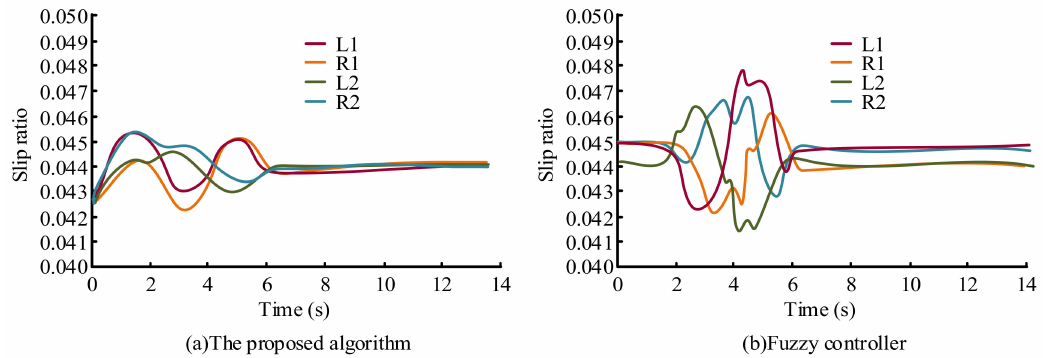
Figure 6. Difference of slip ratio under regulation of two algorithms.